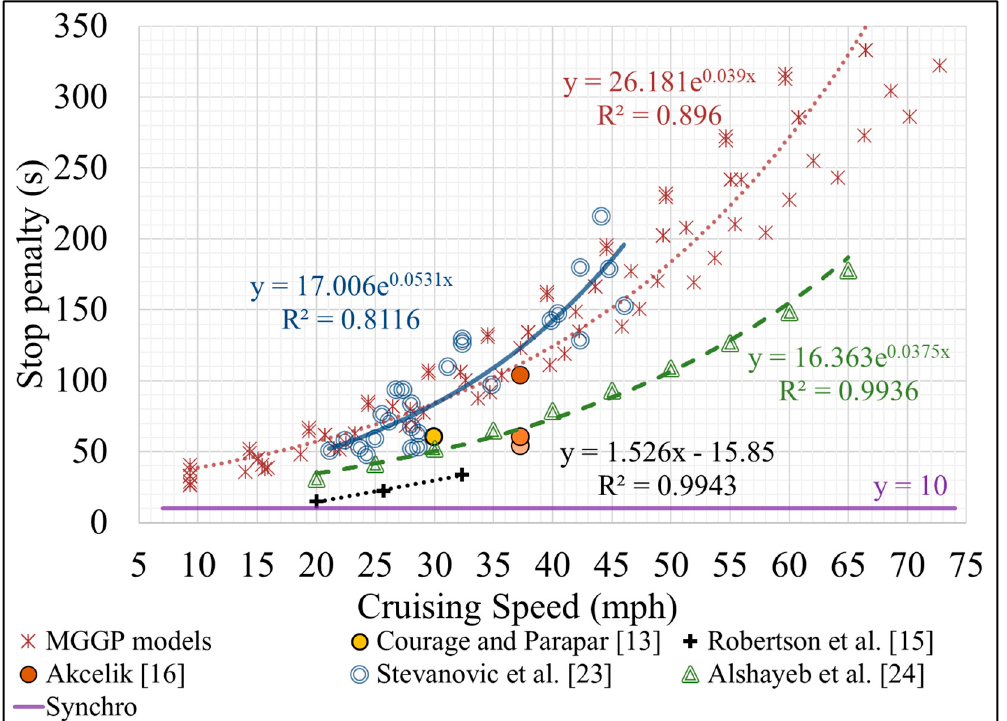
Figure 11. Stop penalty vs. cruising speed from various studies [13,15,16,21,23,24].